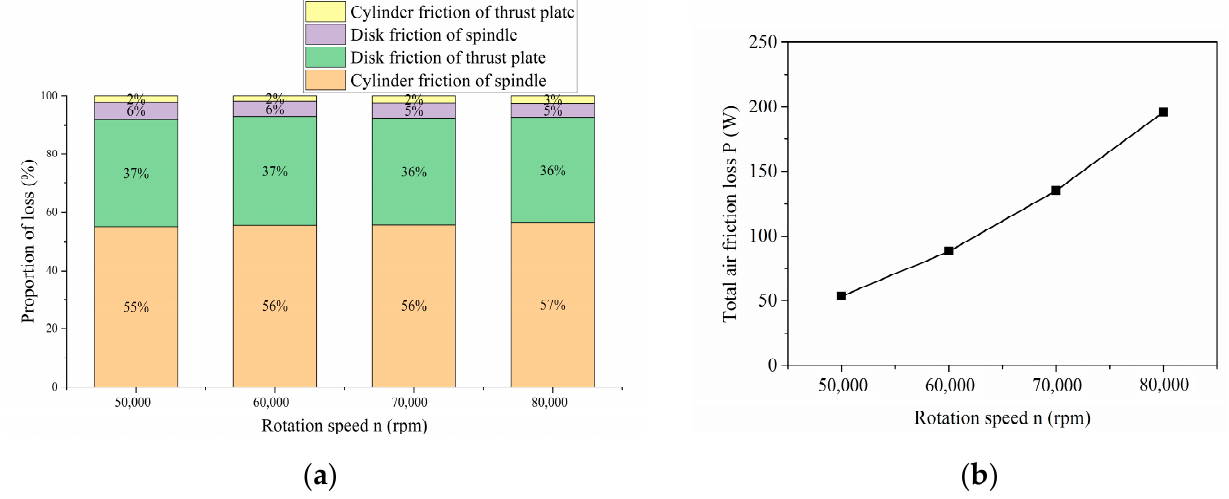
Figure 8. Relationship between air friction loss and revolution of air compressor rotor. ( a ) Relationship between air friction loss and revolutions of each part. ( b ) Relationship between air friction loss and revolutions.